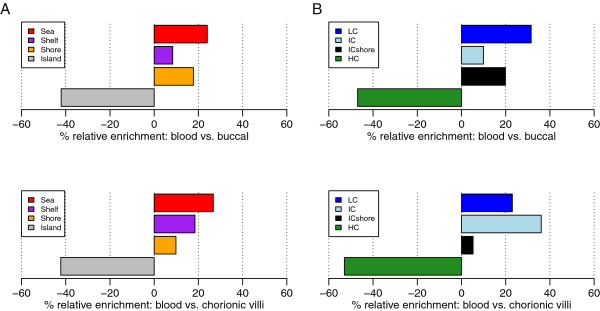
Enrichment of differentially methylated probes in many CpG classes. Probes that were differentially methylated between blood and buccal samples (n = 69,174), or between blood and chorionic villus samples (n = 91,255), were assessed for enrichment in (A) Illumina and (B) HIL-annotated CpG classes. Enrichment was plotted as ‘percentage relative enrichment’, representing the enrichment of tDM probes relative to the total percentage of probes within each CpG class. Negative percentage relative enrichment indicates that tDM probes were depleted in the given probe-type category whereas positive percentage relative enrichment indicates that tDM probes were enriched in the given probe-type category. All enrichment analyses were significant with the exception of ICshore probes in the comparison of blood versus chorionic villi. HIL, high-density CpG island (HC), intermediate-density CpG island (IC) and non-island (LC); ICshore, intermediate-density CpG island shore; tDM, differentially methylated between tissues.